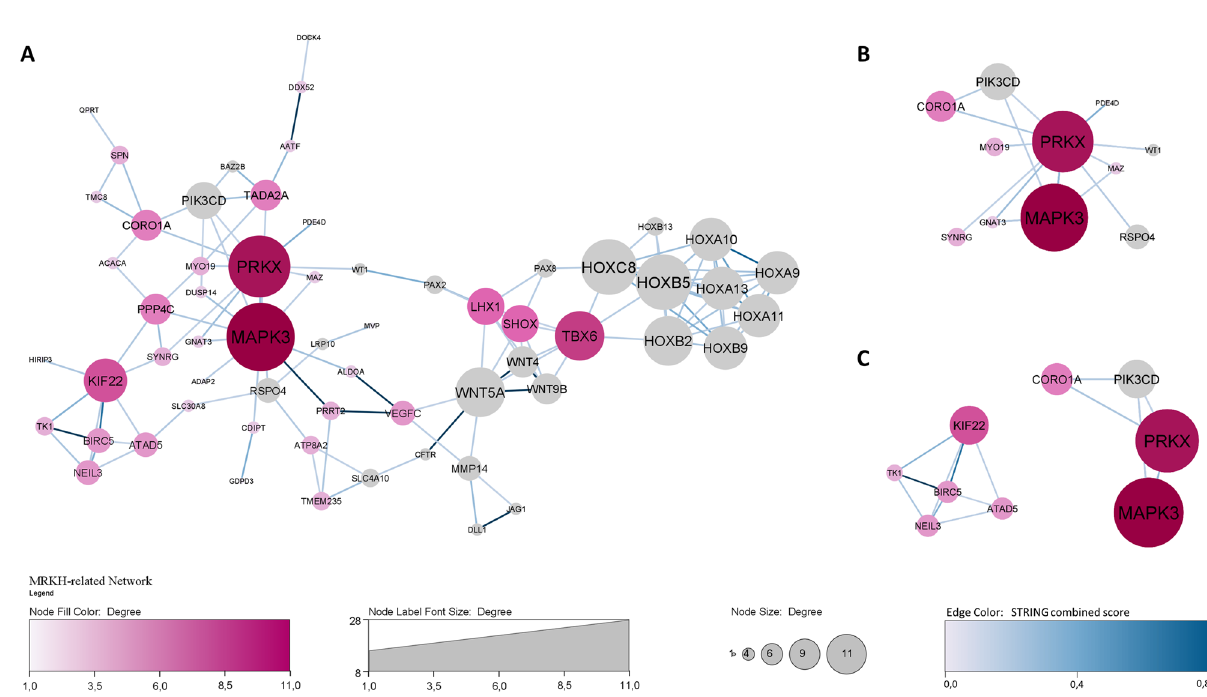
Figure 4. PPI network analysis. (A) Confidence-based network of protein–protein interactions including protein-coding genes located in the CNVs identified in the present study (purple nodes) and candidate genes from the literature (grey nodes). Nodes and font size are positively related to connectivity degree, which is further underlined by colour gradient for CNVs-related genes. Edges colour gradient is associated with STRING combined score, computed by combining the probabilities from the different evidence channels and corrected for the probability of randomly observing an interaction. (B) Focus on PRKX interactions with its first neighbours, functionally involved in movement of cells or subcellular components and cell migration (GO processes, p < 0.05). (C) The two most relevant clusters containing the highest percentage of CNVs-related genes, involved in cytoskeleton organization and regulation of cell migration